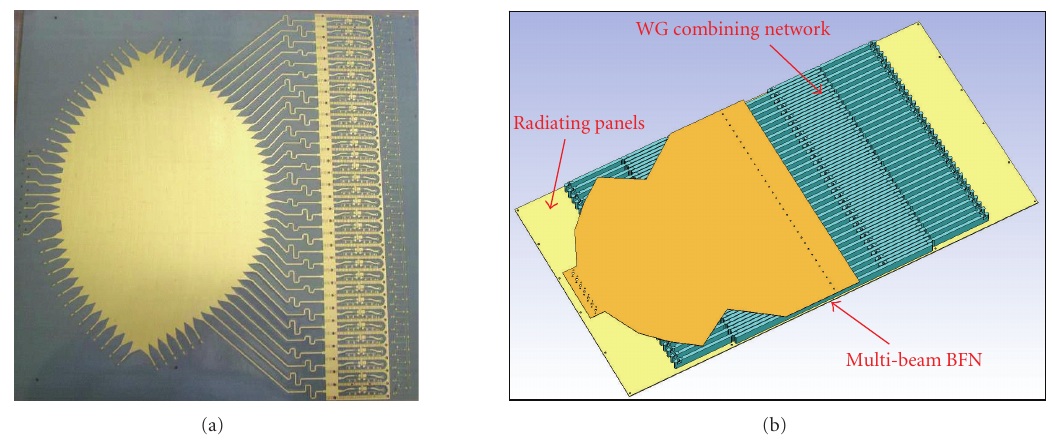
Figure 6: Fabricated active Rotman lens (a); schematic 3D view of the final antenna (b).